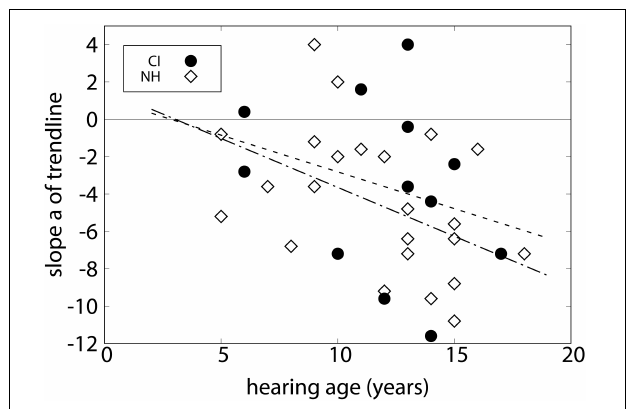
FIGURE 4 | Slopes of the chord preferences of experiment 2 are shown as a function of the hearing age for CI listeners (circles) and NH listeners (diamonds) with corresponding correlation lines. The falling correlation lines indicate a tendency for increasing preference for more consonant chords for more experienced listeners in both